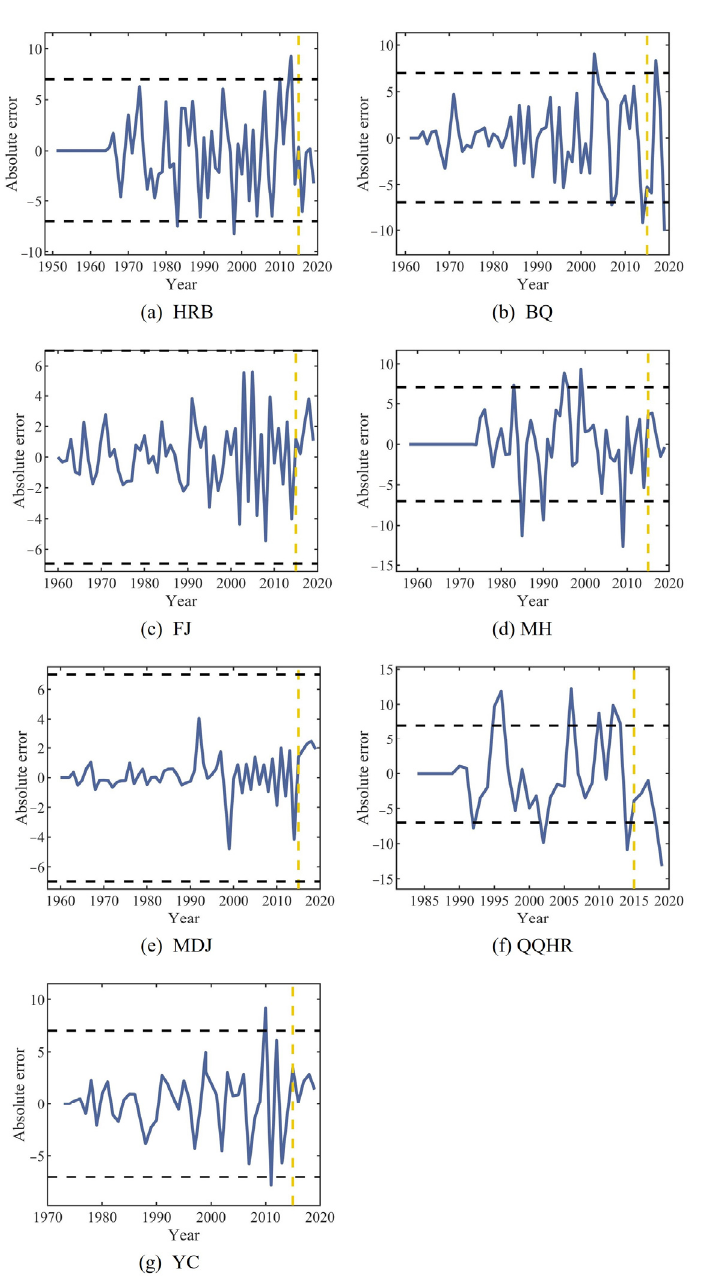
Figure 3. The absolute error ( AE ) of the LSTM at each station in Heilongjiang Province (the black dashed line represents the maximum allowable error stipulated by the standard for hydrological information and hydrological forecasting, and the yellow dashed line divides the training period and the forecast period). Table 4. The absolute error range, MAE, and QR of LSTM at each